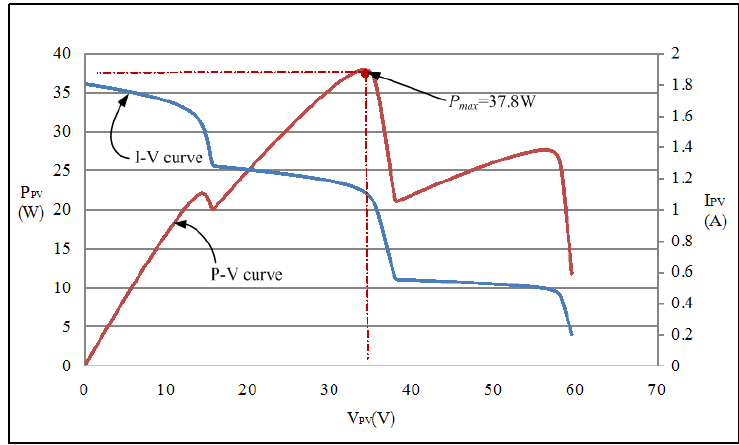
Figure 9. I–V and P–V characteristic curves of the three-serial and one-parallel module array with 0%, 30%, and 70% shading.